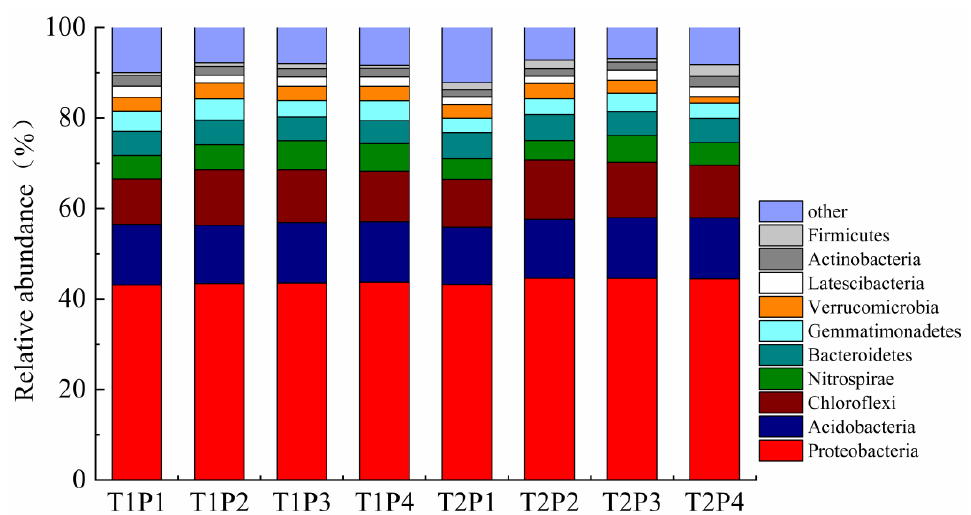
Figure 7. Relative abundance of main soil bacterial communities at phylum level under different treatments in 2020. Note: T1, no straw return; and T2, straw returning. P — No P application; P2 — P application on both rapeseed and rice; P3 — P application on rapeseed; P4 — P application on rice.